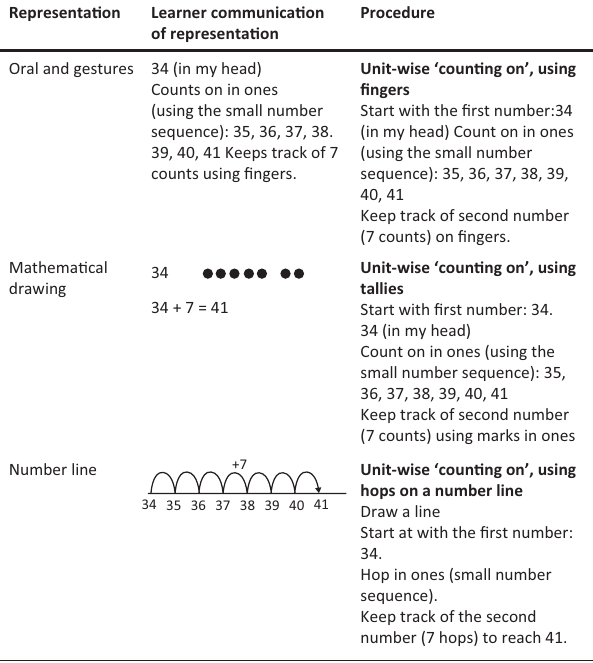
FIGURE 2: Exemplar representations and related procedures for a ‘count on in ones’ strategy for